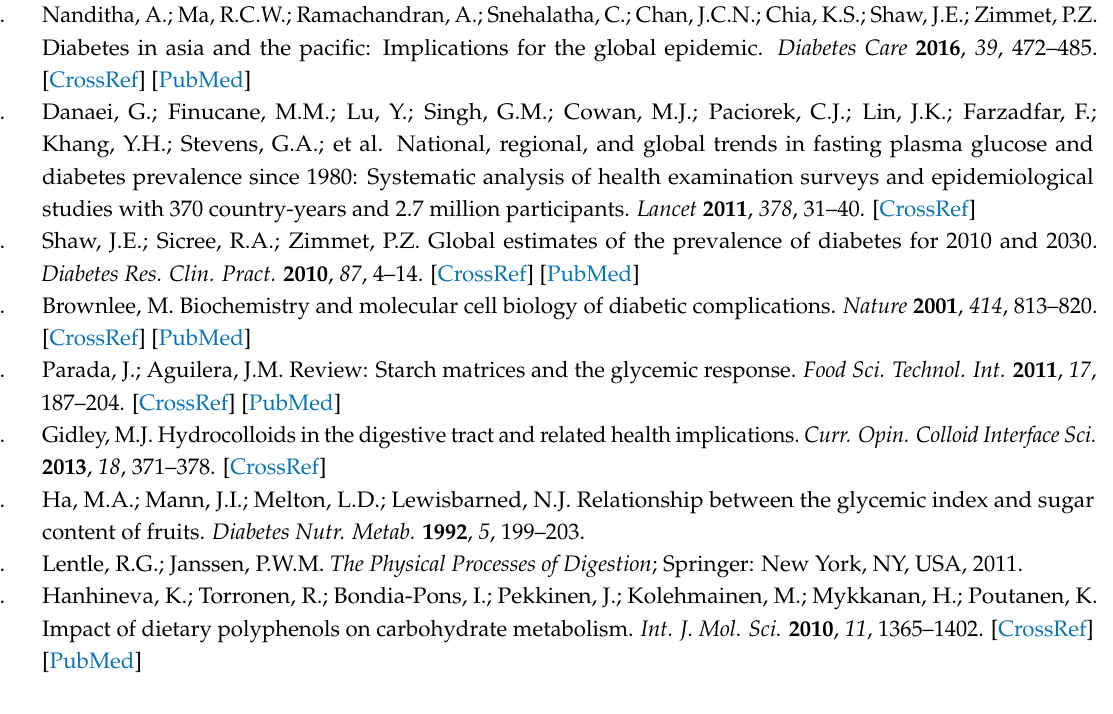
Supplementary Table S1: CONSORT